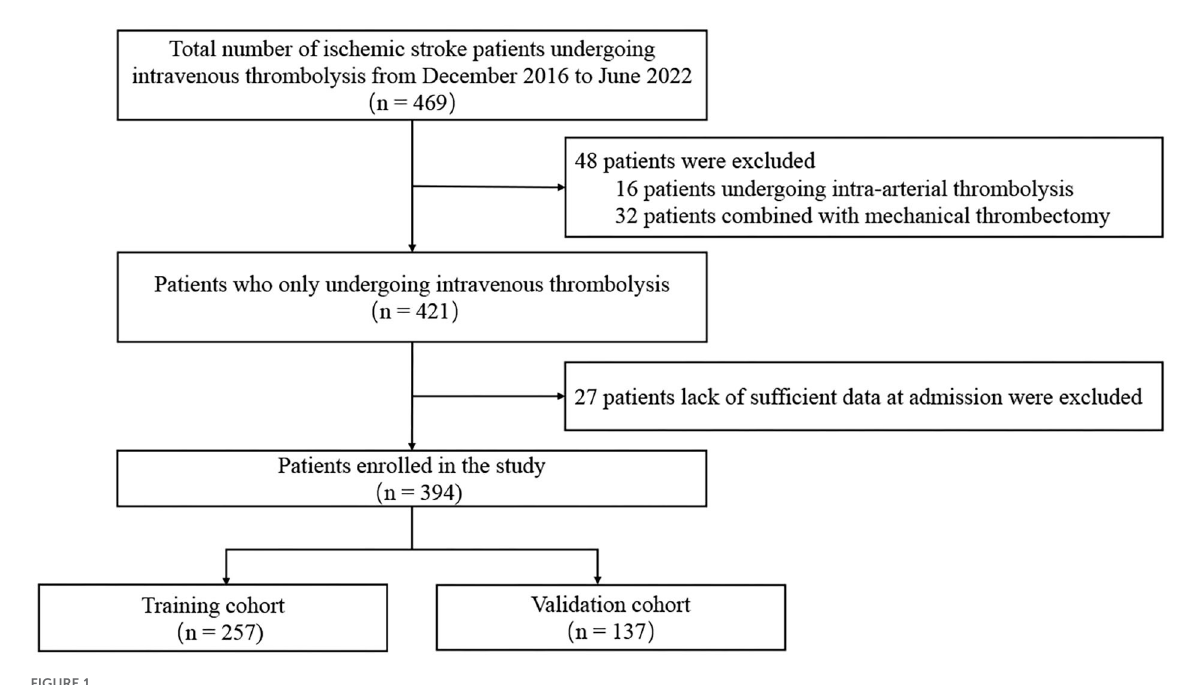
FIGURE1 Flow chart of patient